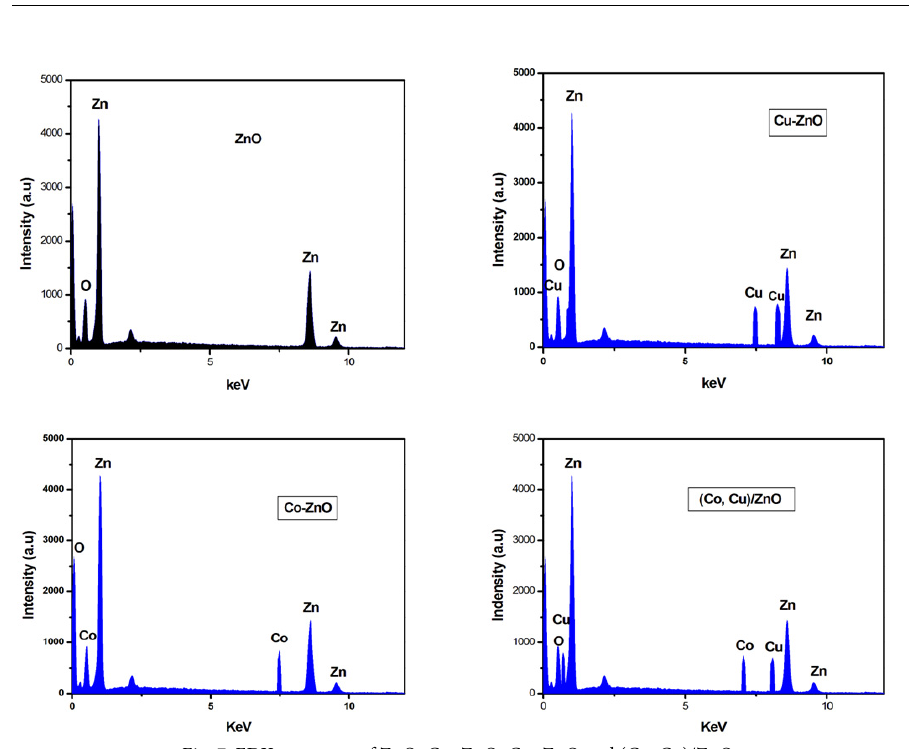
Fig. 7. EDX spectrum of ZnO; Cu–ZnO; Co–ZnO and (Co,